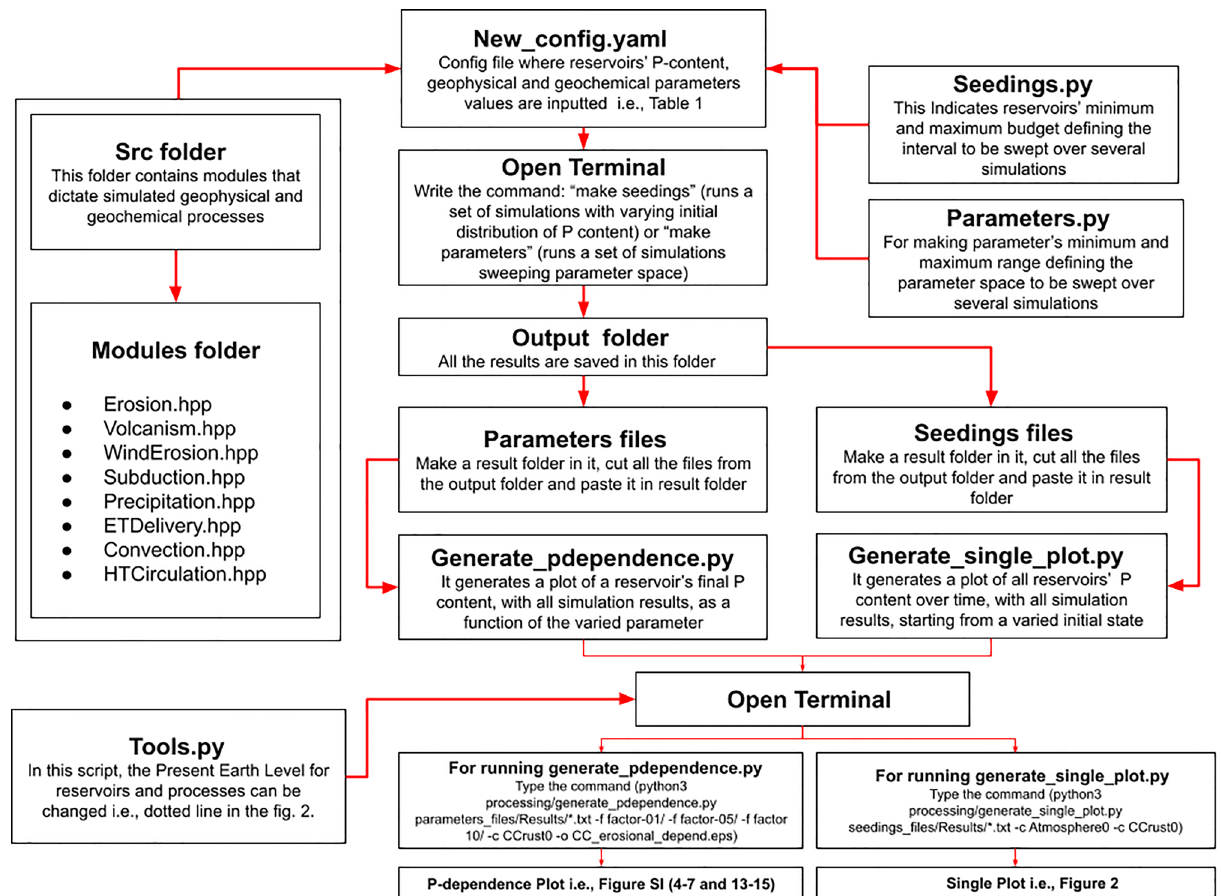
Figure 3. Flowchart outlining the computational workflow used in this model. Further details can be found in 22 and in the Supplementary